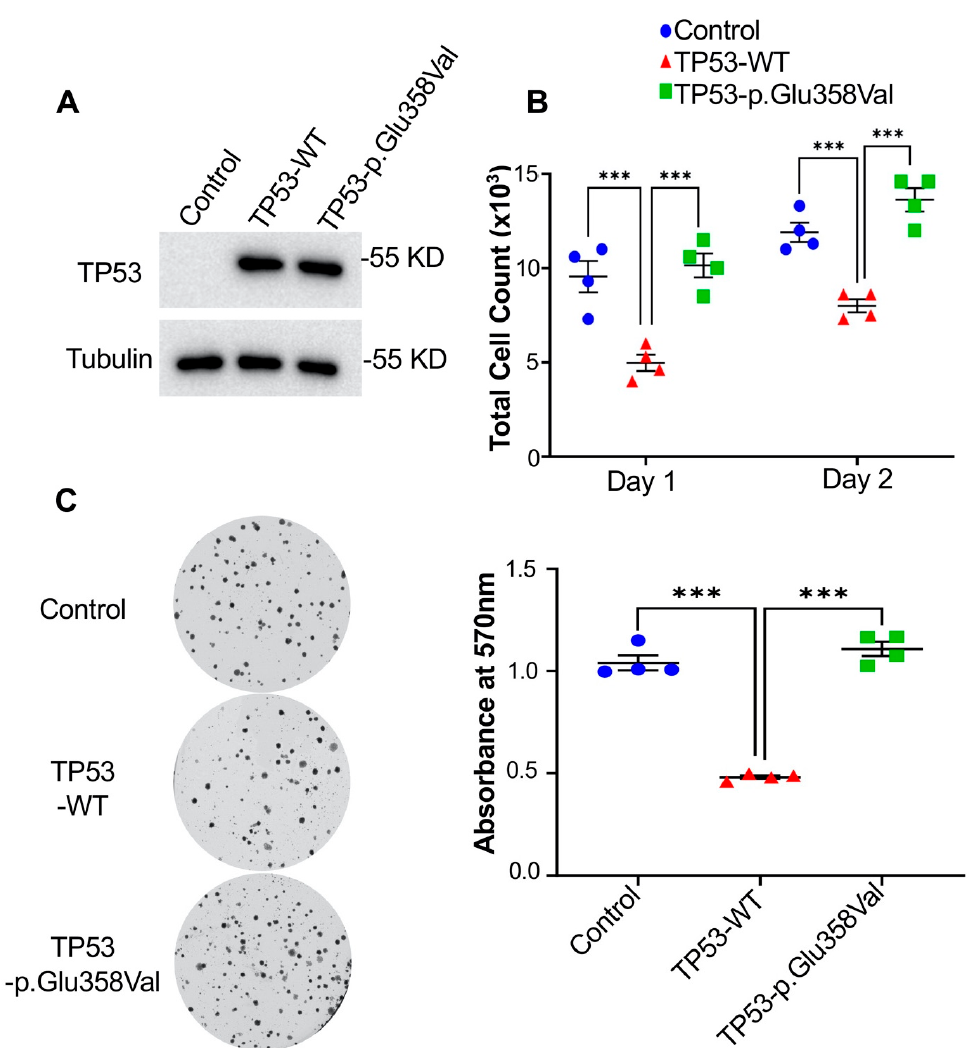
Figure 3. TP53-p.Glu358Val-expressing H2172 cells show increased cell proliferation. ( A ) Immunoblot of TP53 and tubulin proteins in H2172 cells. ( B ) Total cell counts on day 1 and day 2 after seeding. ( C ) Colony formation assay and quantification of crystal violet at 570 nm. *** p < 0.001. 3.4. TP53-p.Glu358Val Mutation Results in Aggressive Xenograft Tumors Growth